Question: What caption would you write for this figure?
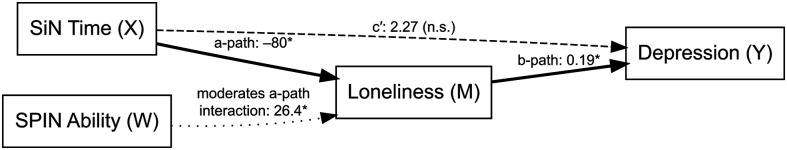
Answer: Schematic showing the relationships among variables in the moderated mediation model. The a-path is the direct association between time spent in speech-in-noise (SiN time) and loneliness (UCLA Loneliness Scale score), moderated by speech perception in noise (SPIN) ability (Quick Speech-in-Noise dB SNR loss). The b-path is the direct association between loneliness and depression, controlling for SiN time. The c'-path is the direct association between SiN time and depression (Patient Health Questionnaire-9 score). n.s. = not significant. *Significant at p < .05.